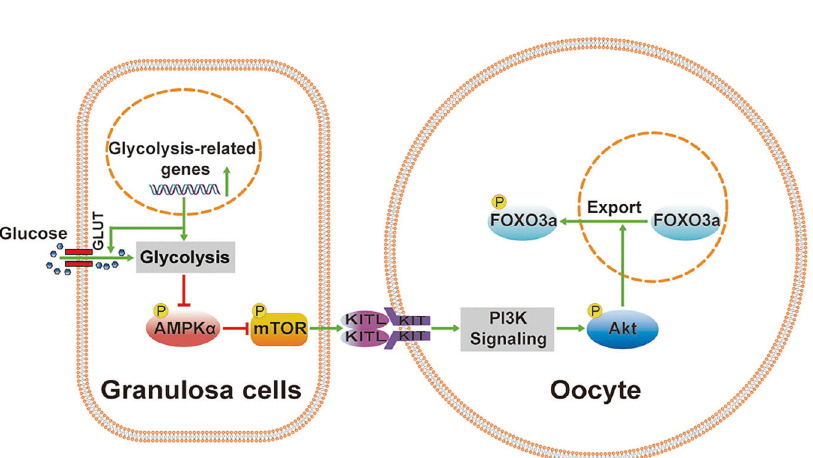
Fig. 6 Effect of short-term pyruvate deprivation on human primordial follicle activation in vitro. a Immuno fl uorescence stain of GLUT4, HK1, PFKL, and PKM2 (green) in human primordial and growing follicles. FOXL2, purple; DAPI, blue. Scale bars: 20 μ m. b , c Log 2 FPKM values were extracted from previously published data (GSE107746). The expression levels of isoforms in each family of HK , PFK , ALDO , ENO, and LDH in human granulosa cells of primary follicles ( n = 15 follicles, b ), and the expression levels of HK1 , PFKL , ALDOA , ENO1 , PKM , and LDHB in human granulosa cells of primordial ( n = 8 follicles) and primary follicles ( n = 15 follicles, c ). GCs granulosa cells, pre-GCs pre-granulosa cells. d – g Human ovarian fragments were directly fi xed in 4% PFA (noncultured), or cultured in standard medium (control), or cultured in the pyruvate- free medium for 2 days and then in standard medium for indicated days (pyruvate-free group). The fragments were collected after 3 days ( e , g ) and 6 days ( d , f ) of treatment, respectively. d , f Morphological comparison of human ovarian tissue fragments ( d ) and the proportion of primordial (arrowheads, f ) and growing follicles (arrows, f ) in the control and pyruvate-free group. ( n = 5 independent experiments). Nuclei were stained by hematoxylin. Scale bars: 50 μ m. e The protein levels of GLUT4, HK1, PFKL, and PKM2 in the noncultured, control, and pyruvate- free groups. g The protein levels of p-AMPK, p-mTOR, p-Akt, and p-FOXO3a in the noncultured, control, and pyruvate-free groups. The representative images are shown. In western blot results, the levels of total AMPK, mTOR, Akt, and FOXO3a were used as the corresponding